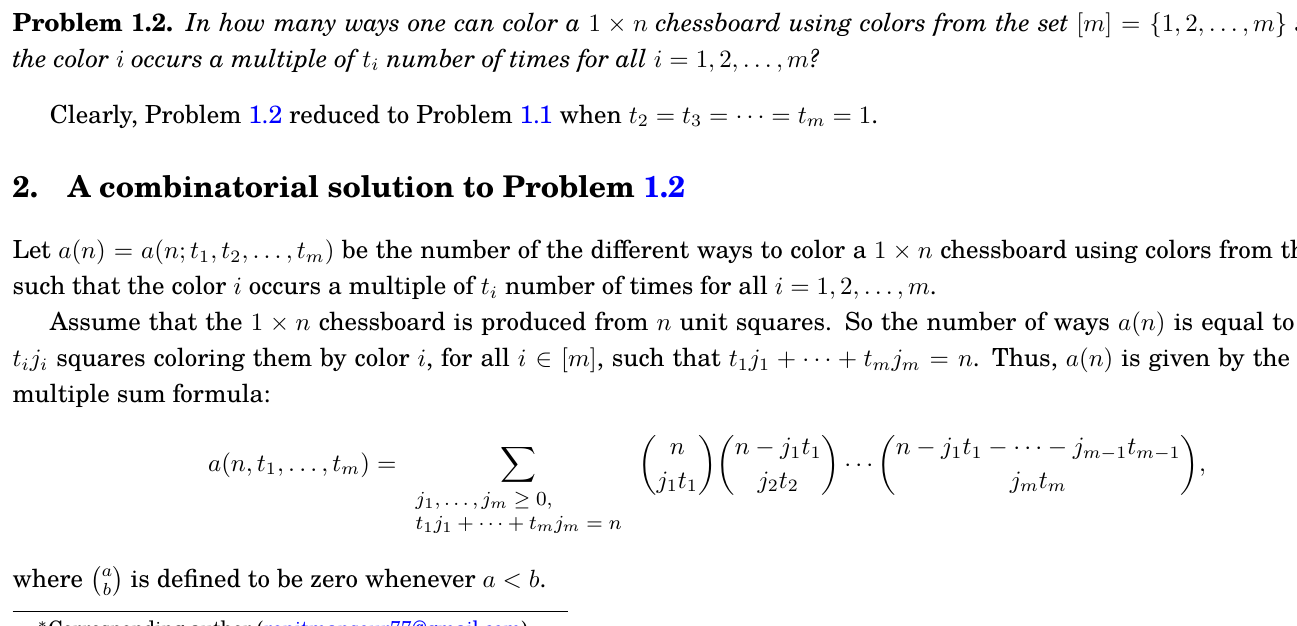
Figure 1: Coloring a 1 × 4 chessboard by black and